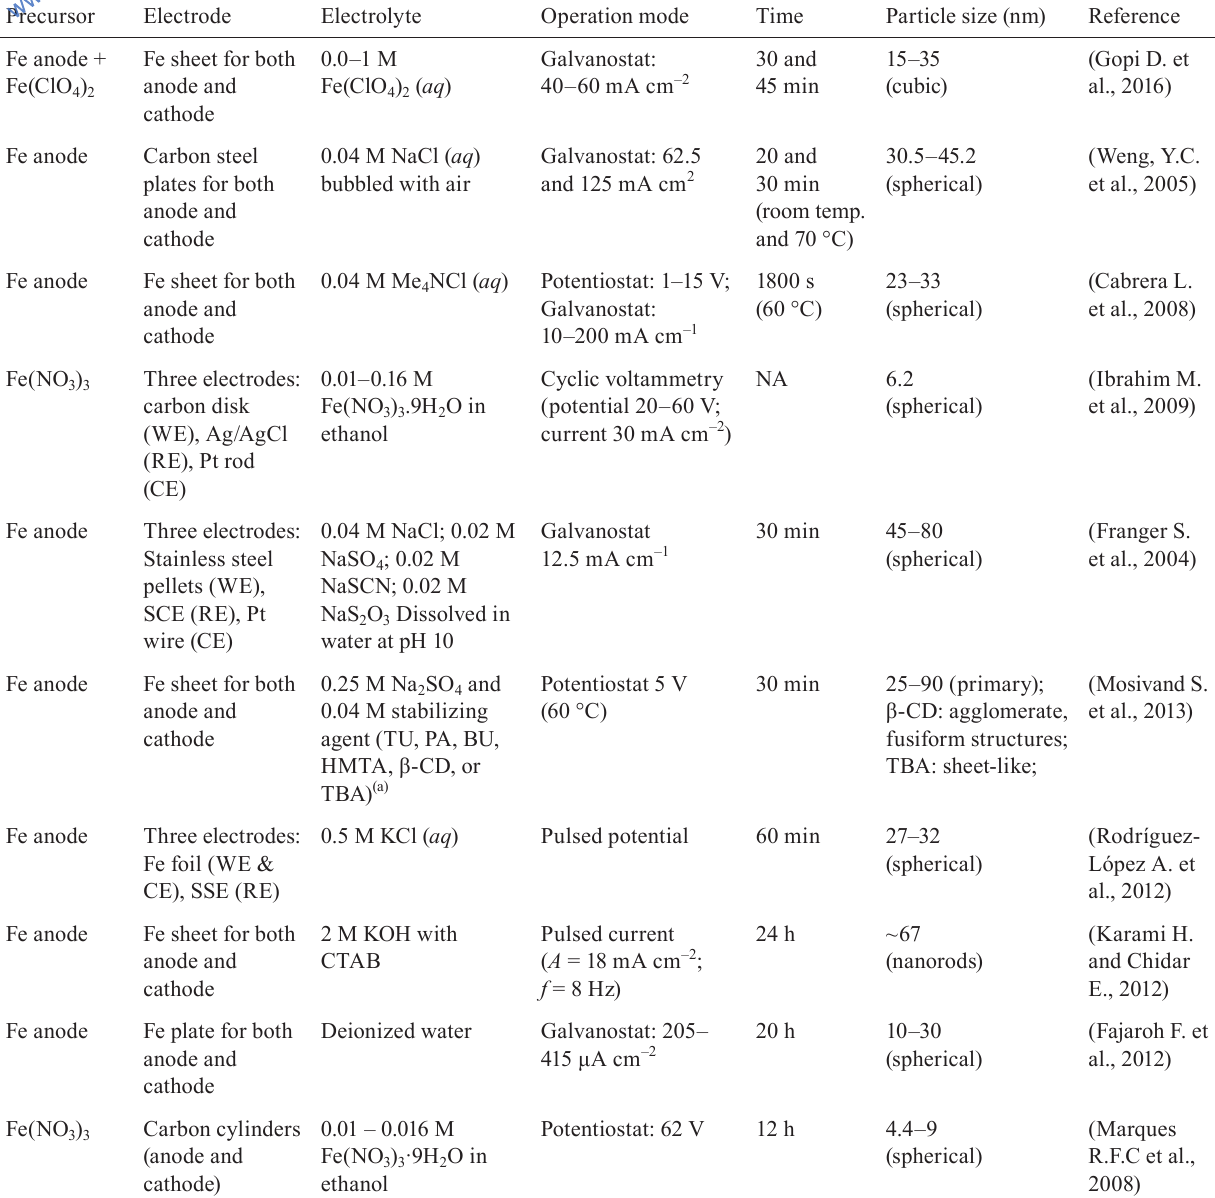
Table 3 Selected studies on synthesis of magnetite nanoparticles by electrochemical method. Precursor Electrode